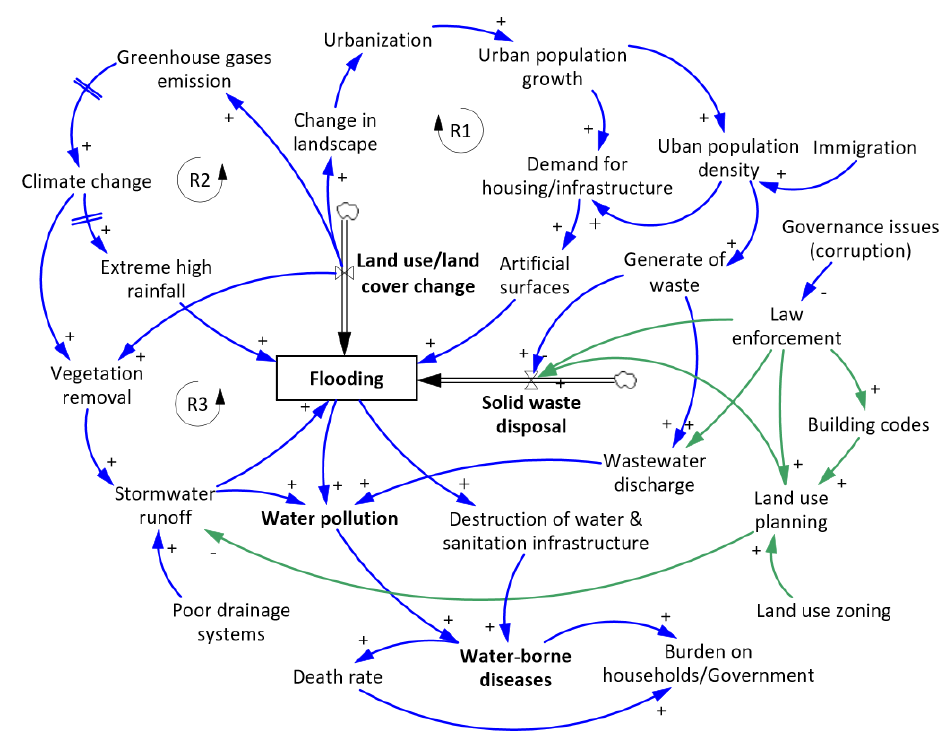
Figure 5. Flood sub-model. The blue arrows show the connections between the variables, while the green arrows indicate the interventions altering the state of these variables. Data source: based on primary data collection in the Odaw River catchment in Ghana, in April 2019.